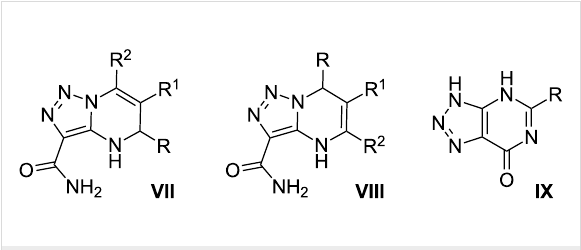
Figure 2: Some possible products of MCRs involving 4-amino-5- carboxamido-1,2,3-triazole and carbonyl